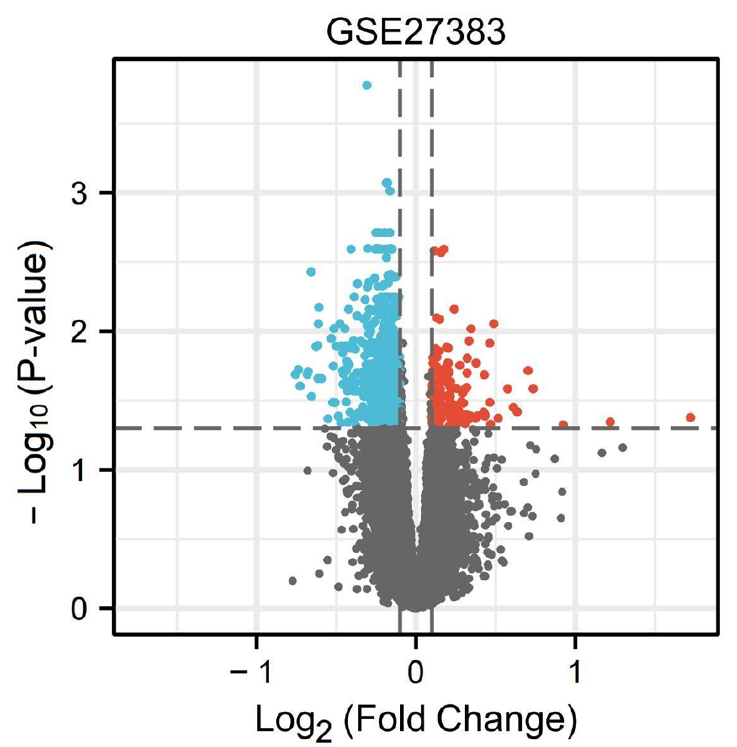
Figure 1. Identification of DEGs between schizophrenia patients and healthy people.